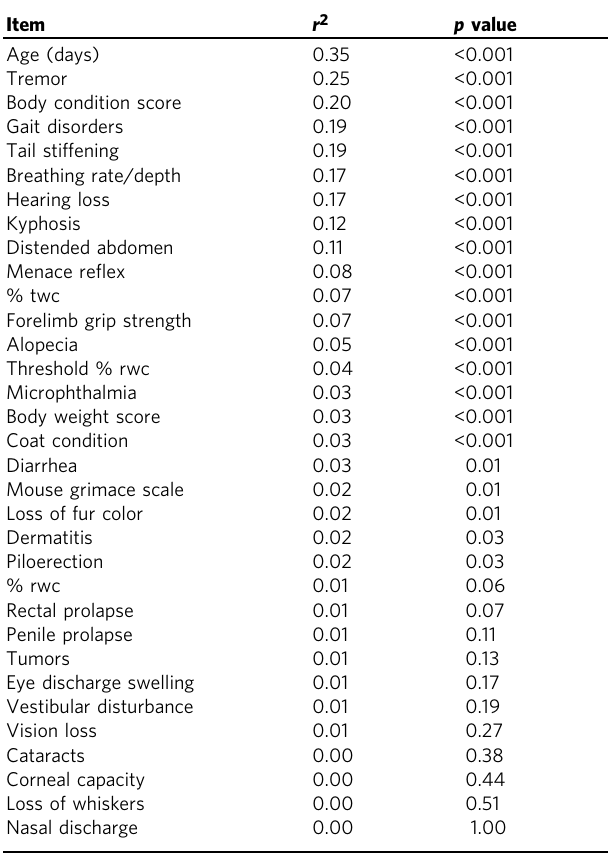
Table 3 Correlation coef fi cients ( r 2 ) and p values for frailty items with life